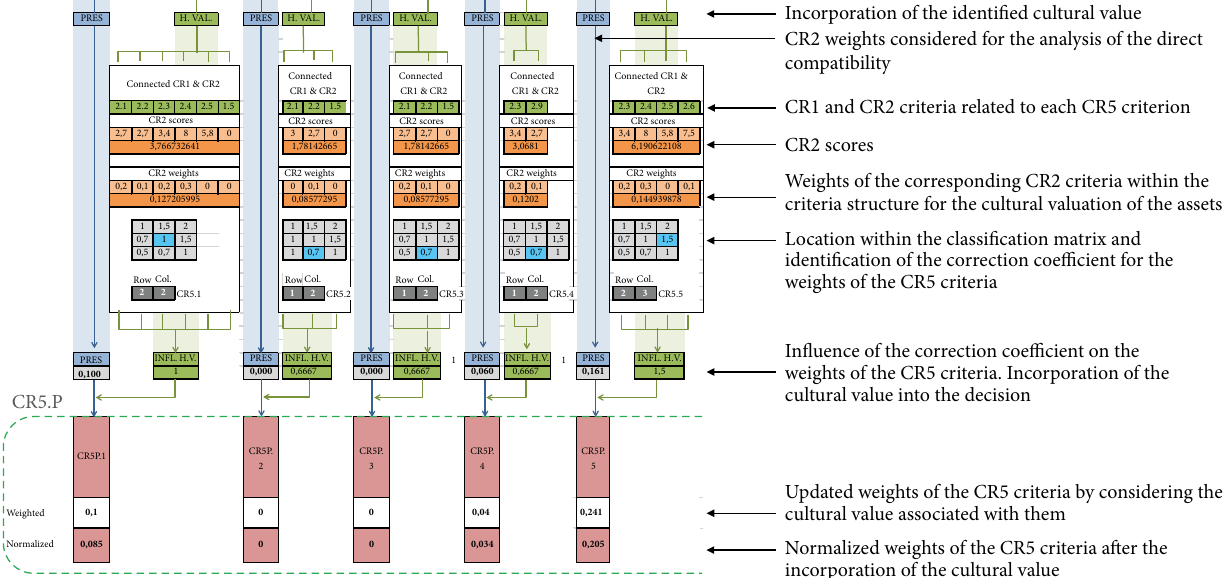
Figure 8: Partial view of the hierarchical structure of criteria for selection of new